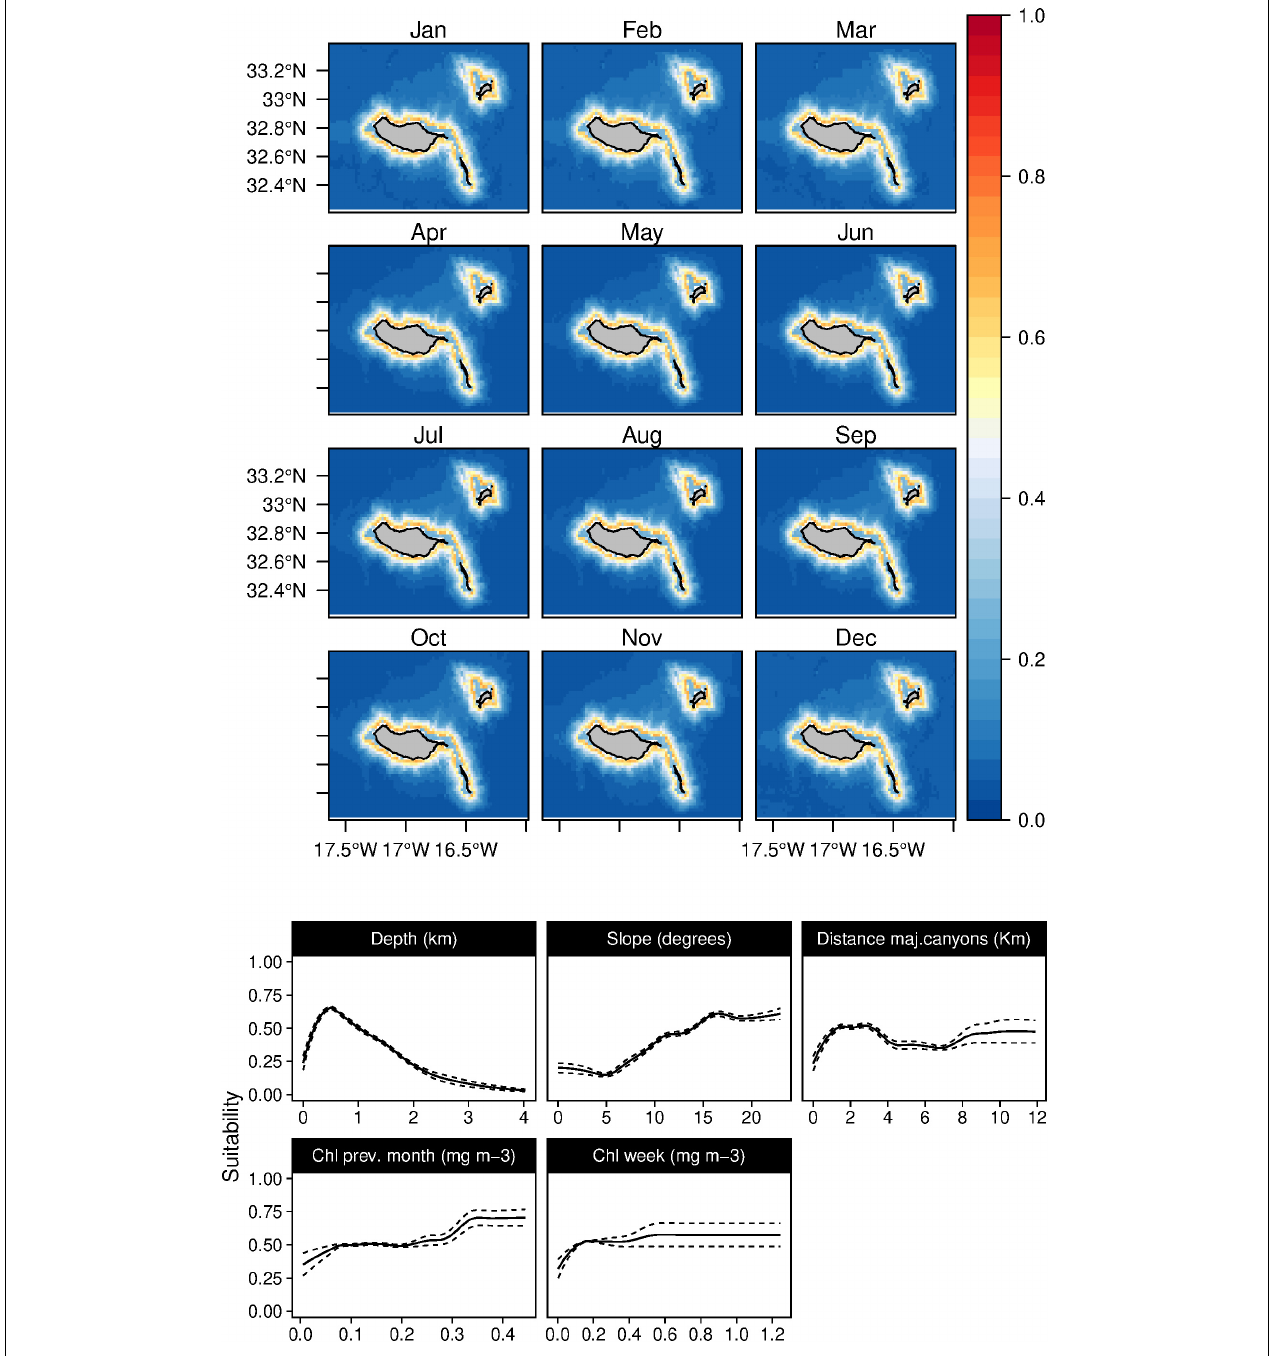
FIGURE 5 | Mean monthly suitability maps (above) and smoothed response curves with standard deviation (below) in the Madeira archipelago for Tursiops truncatus for the “8-days” models. In the maps, red represents more suitable and blue less suitable. Responses curves are ordered by percent contribution of the environmental